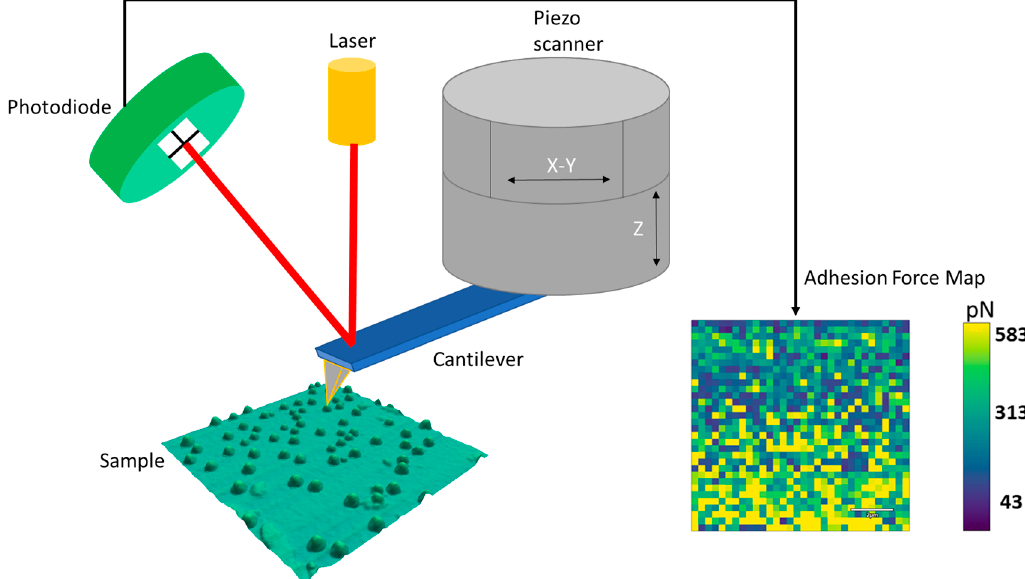
Figure 3. Schematic of the AFM setup. As the functionalized tip approaches the surface, it senses surface properties and causes the cantilever to bend. The position of the laser spot reflected from the cantilever onto the photodiode detector changes in response and the resulting deflection is recorded by the detector. Depending on the tip-sample distance, the feedback controller either allows the piezoelectric scanner to adjust the position of the tip, or the data is transmitted through topography images and / or force maps.